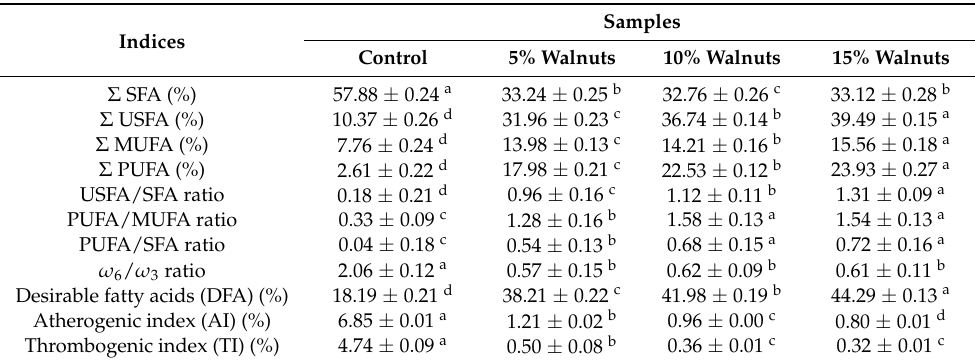
Table 3. The ratio of fatty acids and health lipid indices of processed cheeses containing 0, 5, 10, and 15% walnut